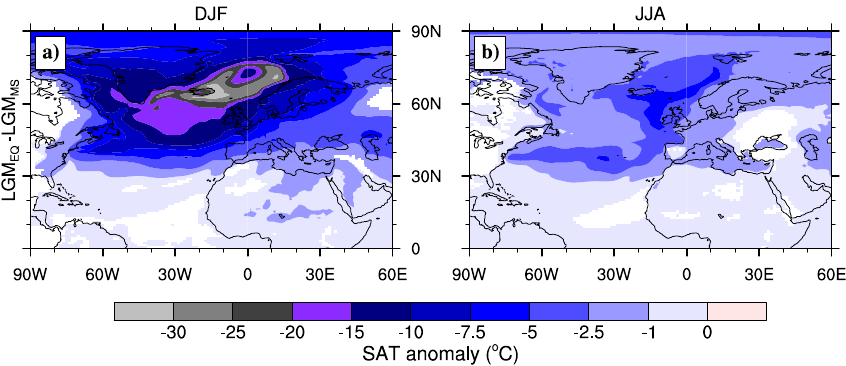
Fig. 5. Winter (DJF, a ) and summer (JJA, b ) SAT difference between LGM EQ and LGM MS . Only values that are statistically significant at the 5% level based on the two-sided Student’s t-test are